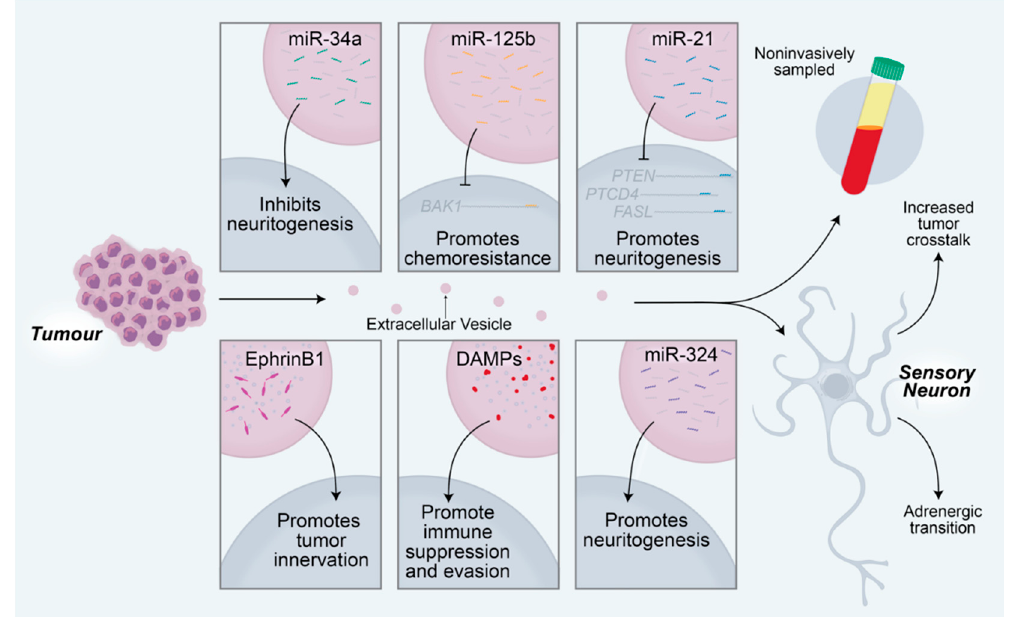
Figure 3. Tumor-derived extracellular vesicles promote tumorigenesis via manipulation of the nearby sensory neurons. MicroRNAs delivered to sensory neurons regulate neuronal changes that subsequently affect tumor activity. MiR-34a from oral cavity squamous cell carcinomas inhibits neuritogenesis in nearby sensory neurons. MiR-125b inhibits BCL2 antagonist killer 1 (BAK1) translation, resulting in chemoresistance of the tumor. MiR-21 promotes sensory neuritogenesis through regulation of PTEN, PTCD4, and FASL transcripts. EphrinB1 proteins delivered to nearby neurons promote the growth of the neurons into the tumor. Damage-associated molecular pattern (DAMP) proteins, including S100A4, S100A13, BSF, and LGALS9, promote immunosuppression, which facilitates immune evasion of the tumor. MiR-324 from OCSCCs promotes neuritogenesis in nearby sensory neurons. Extracellular vesicle contents can be sampled non-invasively from a variety of body fluids, including peripheral blood, saliva, cerebrospinal fluid, and urine, among others. Extracellular vesicles promote increased crosstalk between neurons and tumors and drive a sensory to adrenergic transition in receiving neurons.